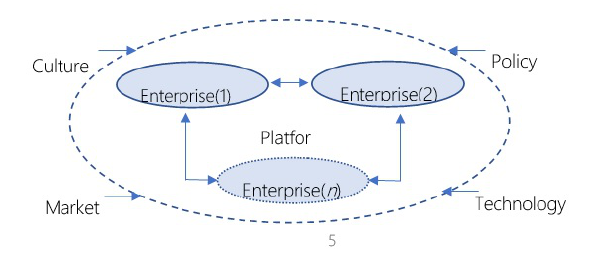
Fig. 1 Innovation ecosystem relationships based on technology